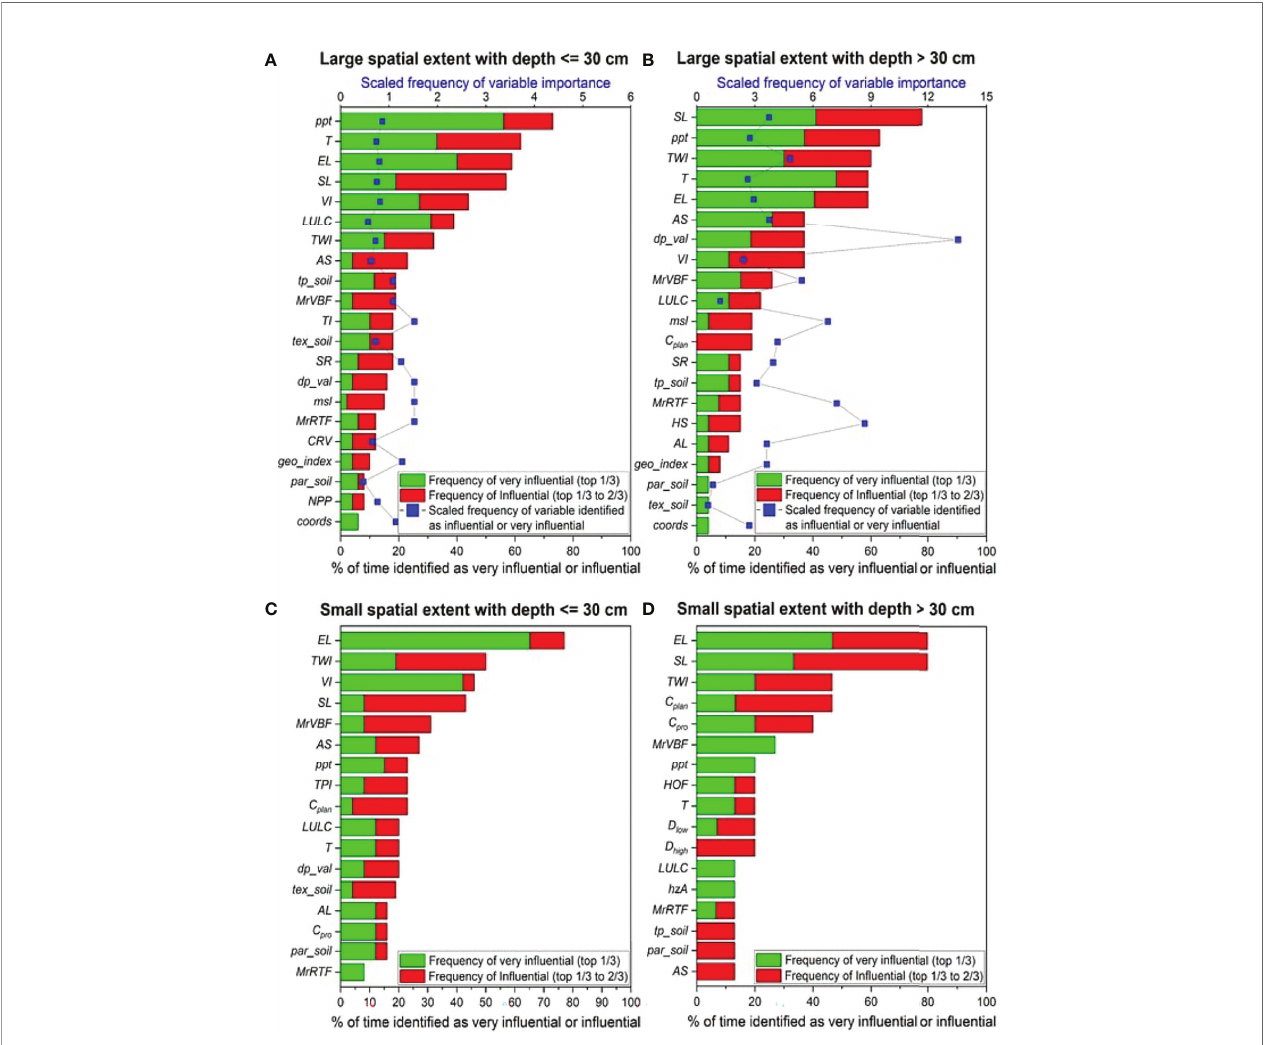
FIGURE 4 | The frequency of covariates identi fi ed as important for quantifying soil organic carbon from agricultural lands based on (A) large spatial extent studies (>10,000 km 2 ) for top soil layers ( ≤ 30 cm), (B) large spatial extent studies (>10,000 km 2 ) for subsoil layers (>30 cm), (C) small spatial extent studies (<10,000 km 2 ) for top soil layers ( ≤ 30 cm), (D) small spatial extent studies (<10,000 km 2 ) for subsoil layers (>30 cm). Covariates ranked within the fi rst one-third of each record were labeled as ‘ very in fl uential ’ , and the ones ranked between one-third and two-thirds were labeled as ‘ in fl uential ’ . The scaled frequency shown for regional and national scale studies were calculated as the frequency of covariate identi fi ed divided by the times they were used to build SCORPAN